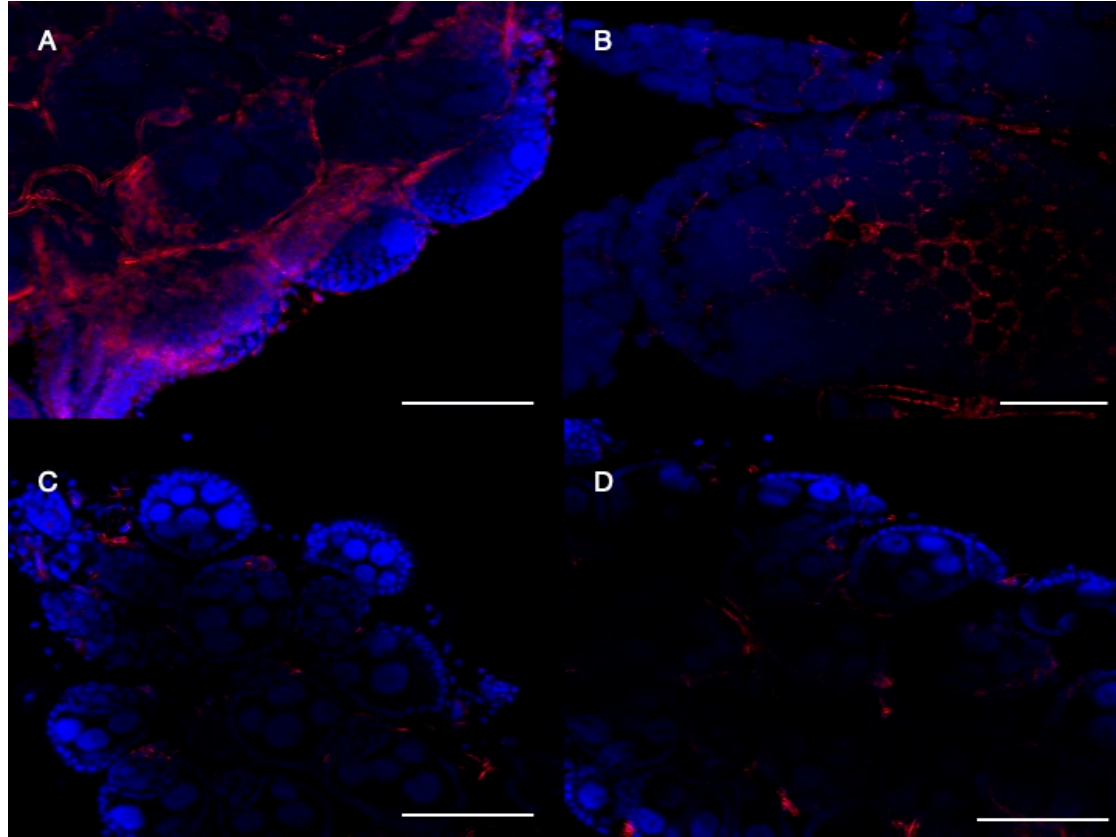
Figure 5. Immunofluorescent detection of CRVP379 in the ovaries of Ae. aegypti . Anti-CRVP379 antibody in red, DAPI (nuclei) in blue. ( A ) Ae. aegypti Liverpool ovaries, 20× magnification. ( B ) Ae. aegypti Liverpool ovaries, 63× magnification, in both ( A , B ). CRVP379 can be seen in the follicular epithelial cells. ( C ) CRVP-pKO ovaries, 20× magnification. ( D ) CRVP-cKO ovaries, 20× magnification. In both CRVP-pKO and CRVP-cKO ovaries, a clear localization of CRVP379 was not observed. Images are representative images of ovaries from each line. Images were obtained by confocal microscopy; Z-slides were stacked to get a single projection. Bar scale ( A , C , D ) = 100 μ m, ( B ) = 20 μ m.